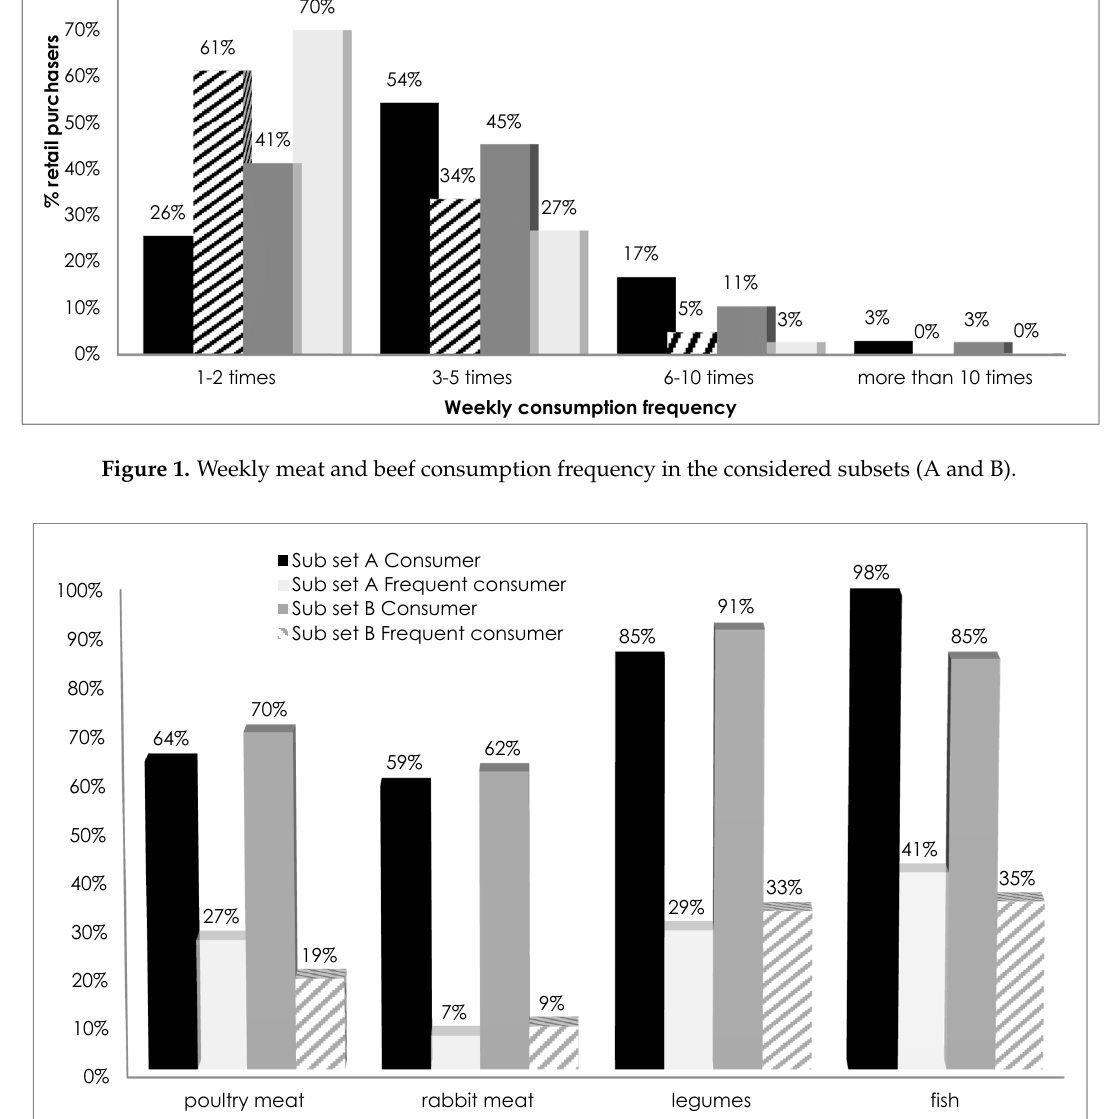
Figure 2. Protein sources: consumers and frequent consumers in subsets A and B.